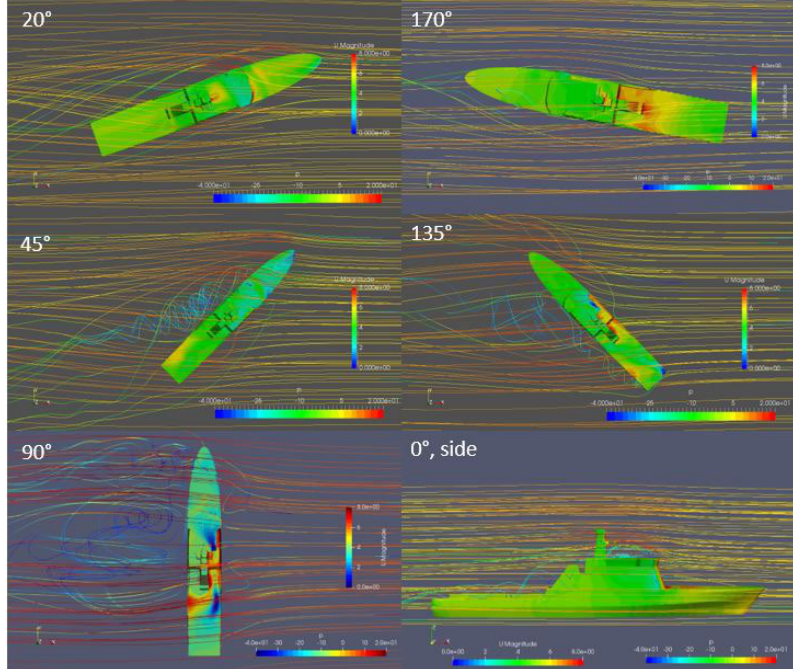
Figure 10. Velocity stream and pressure distribution on the model scale hull form (above the water part) while interacting with the wind at various angles (velocity scale: 0 to 8; Pr. scale : −40 to 20), after reaching a steady-state.